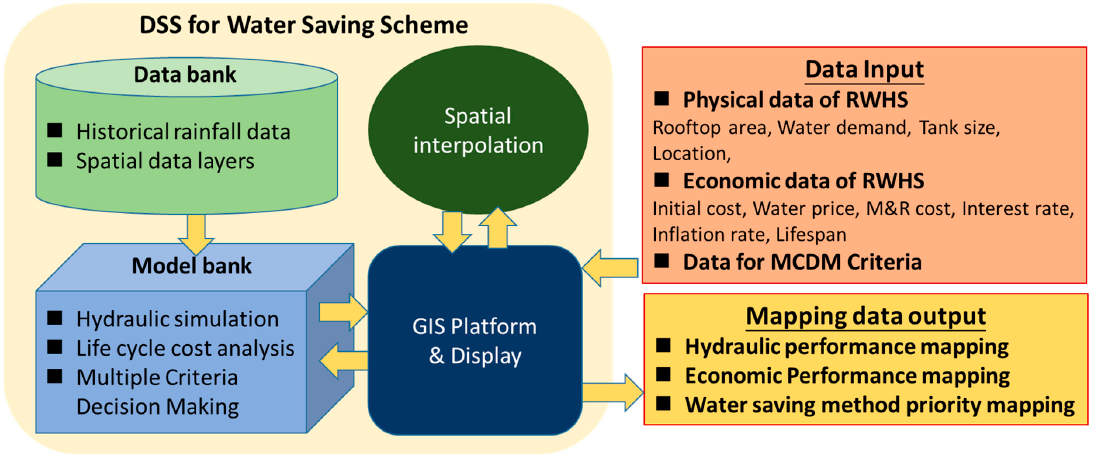
Figure 1. The conceptual framework of DSS for the water-saving scheme.